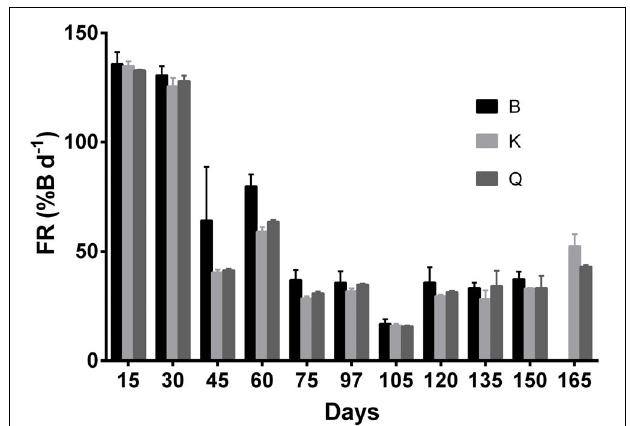
FIGURE 6 | Tank Feeding Rate (FR,% BW d - 1 ) values for cuttlefish reared in different tank types during the growth stage. Data are presented in offset. Vertical bars represent standard